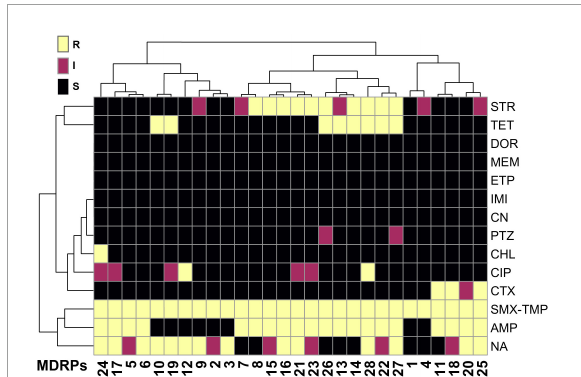
FIGURE3 Heatmap of the phenotypic characterization of the main multi-drug resistance profiles (MDRPs) identified by the Kirby-Bauer Disk Diffusion Susceptibility Test in randomly selected transconjugants. A total of 28 different phenotypic MDRPs were transferred from bacterial communities from the two sites in the La Paz River basin to E. coli CV601 recipients. A single profile was defined as the unique combination of susceptibility, intermediate resistance, or resistance to the 13 antibiotics included in the analysis. Color code: black = susceptible (S), magenta = intermediate (I), and yellow = resistant (R). Antibiotics: AMP, ampicillin;